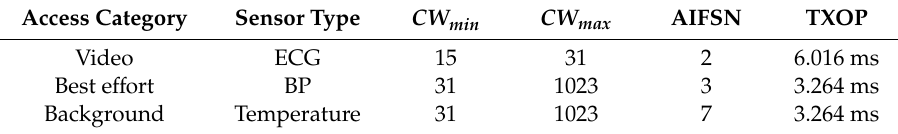
Table 1. Default Enhanced Distributed Coordination Function (EDCF) parameters.